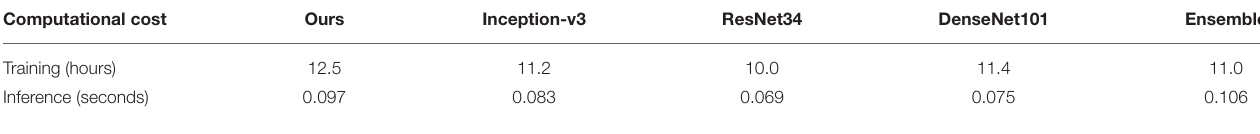
TABLE 1 | Computational cost comparison between the proposed hierarchical deep learning framework and existing deep learning frameworks.